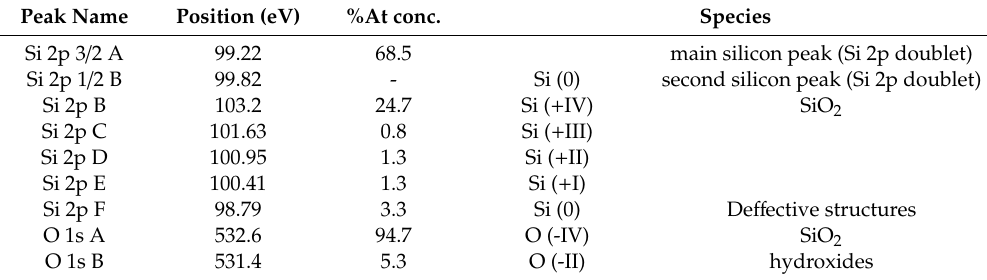
Figure 1. Deconvolution of the Si 2p ( a ) and O 1s signals ( b ) of the Si (1,0,0) wafer. Table 1. The results of X-ray photoelectron spectroscopy (XPS) analysis.